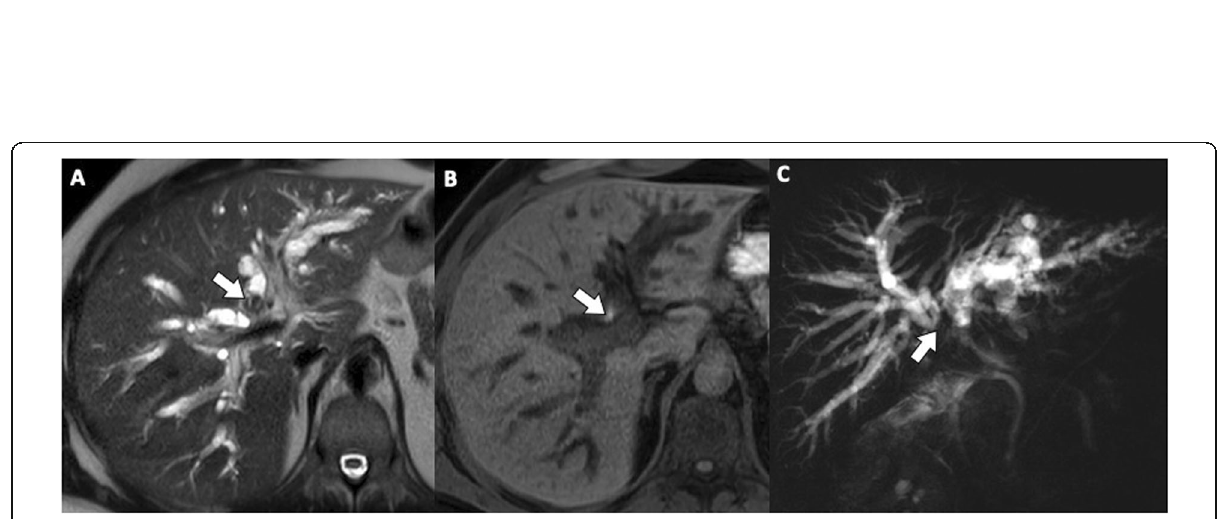
Fig. 4 A 48-year-old man with communicating rupture. MR images on T2-weighted ( a ) and T1-weighted gradient echo ( b ) sequences demonstrate endoluminal biliary content (arrows), hypointense and hyperintense on respective images, at the hilar biliary confluence. On MRCP image ( c ), the endoluminal obstructive biliary content leads to loss of signal intensity (arrow) from the hilar biliary confluence to the common hepatic duct, while the common bile duct is